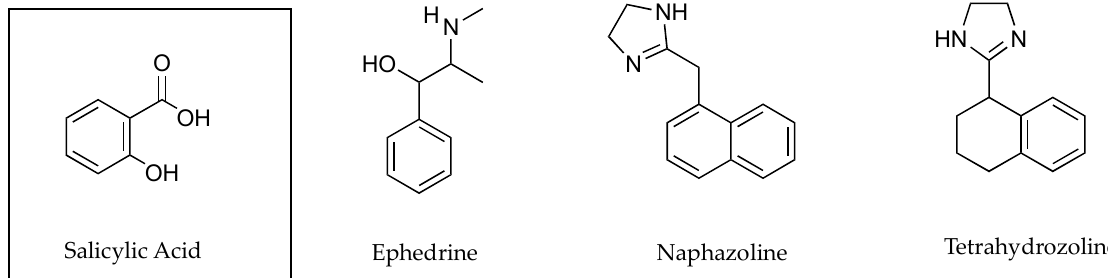
Figure 16. SA and counter ions ephedrine, naphazoline and tetrahydrozoline.